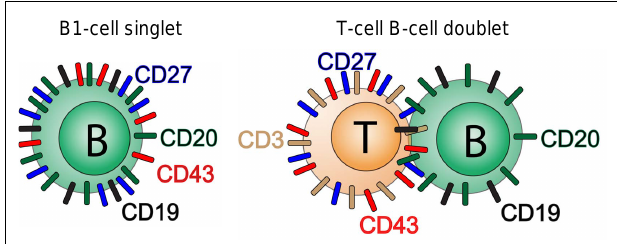
FIGURE 4 | B:T doublets can masquerade as CD20 + CD27 + CD43 + B1 cells. A diagrammatic model for the phenotypic readout of B:T doublets is